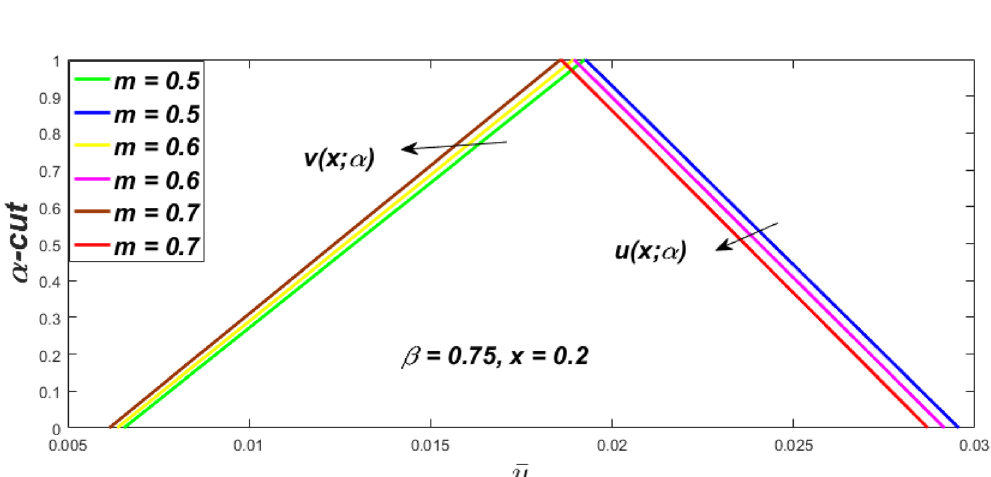
Figure 12. Triangular MF of fuzzy velocity profiles for the impact of m